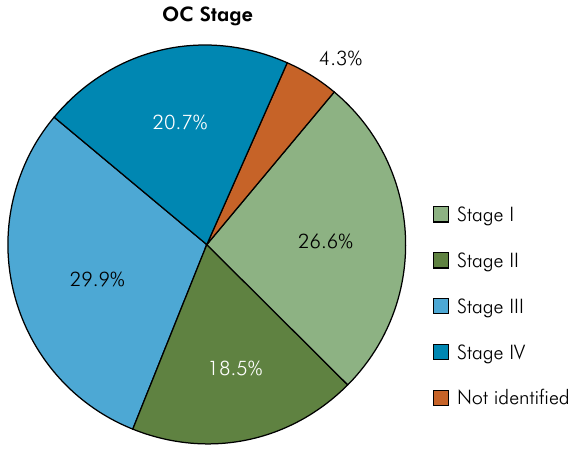
Figure. Distribution of patients according to OC stage at diagnosis.